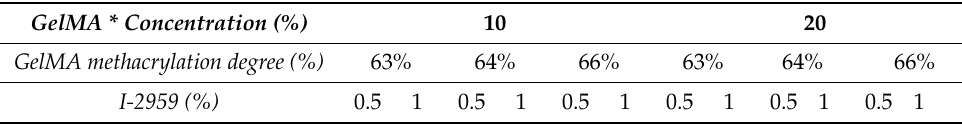
Table 2. The bioink preparation for 3D